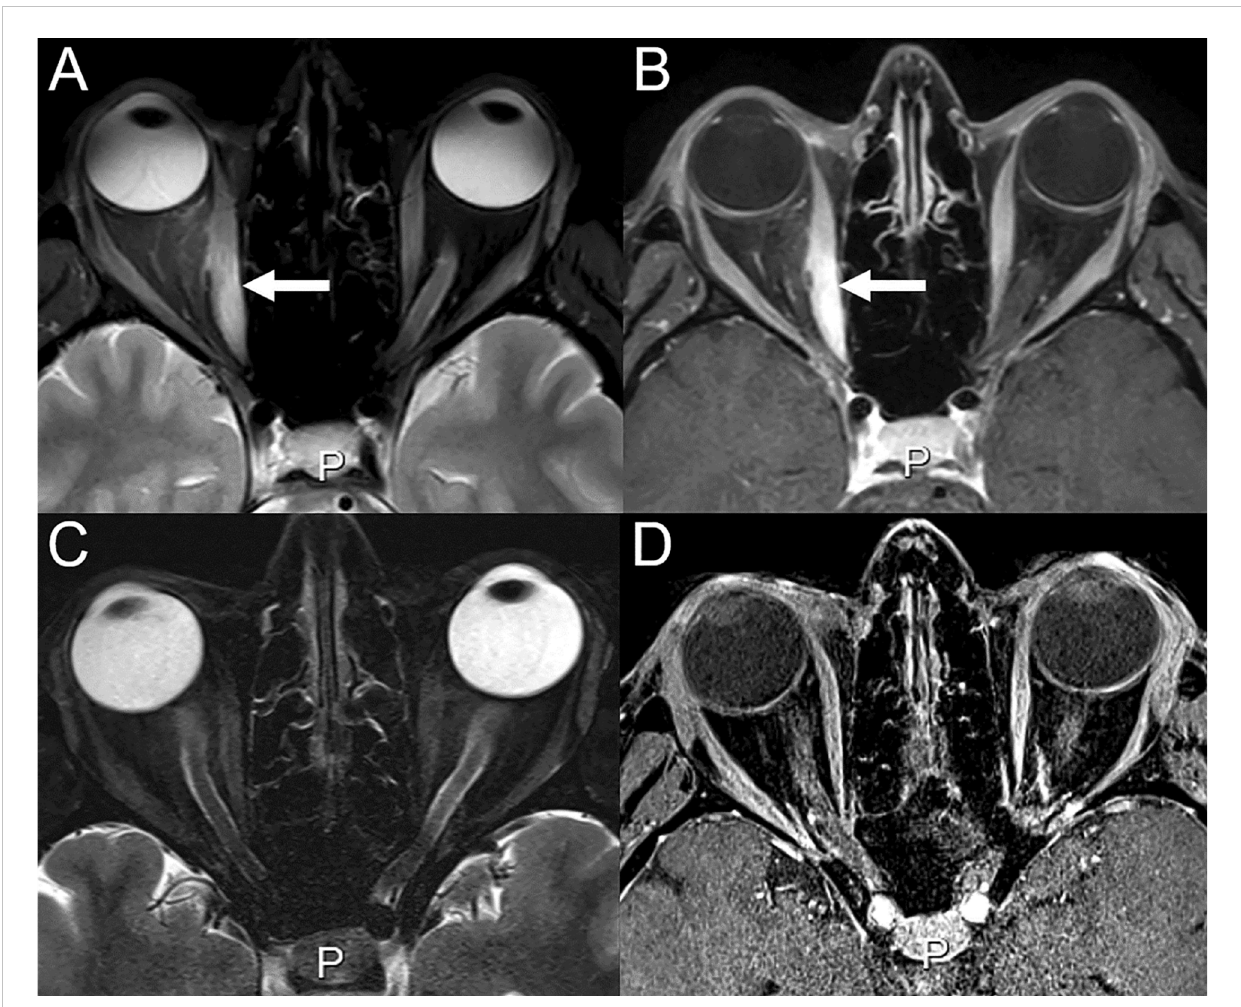
FIGURE 7 Immune-related orbital myositis in a 43-year-old female with cutaneous melanoma treated with ipilimumab (anti-CTLA-4) and nivolumab (anti-PD- 1). After 3 cycles of ipilimumab and nivolumab, the patient reported diplopia. (A) On T2-weighted and (B) contrast-enhanced images, orbital edema, abnormal enhancement and thickening of the right medial occulomotor muscle can be seen, consistent with orbital myositis (arrows). (C, D) MRI at 1 month from treatment discontinuation with disappearance of signs of in fl